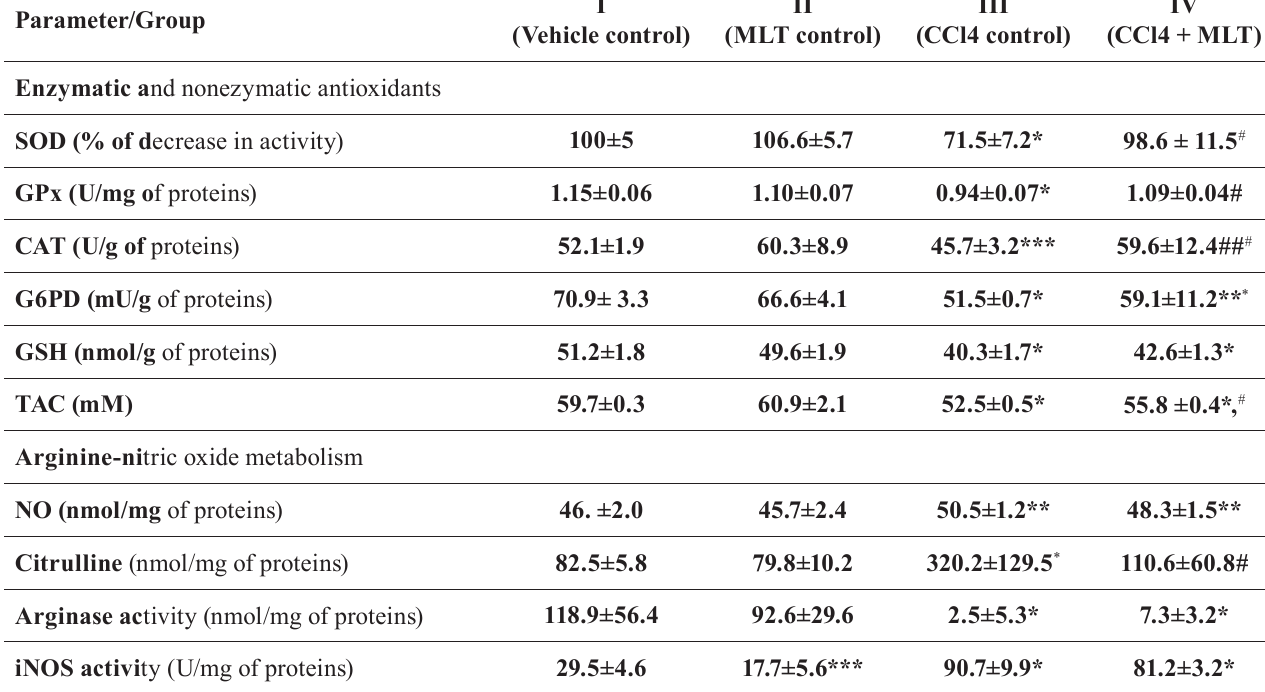
TABLE I - A ntioxidant capacities, and arginine-nitric oxide metabolism parameters estimated in testicular tissue obtained from rats belonging to different experimental groups